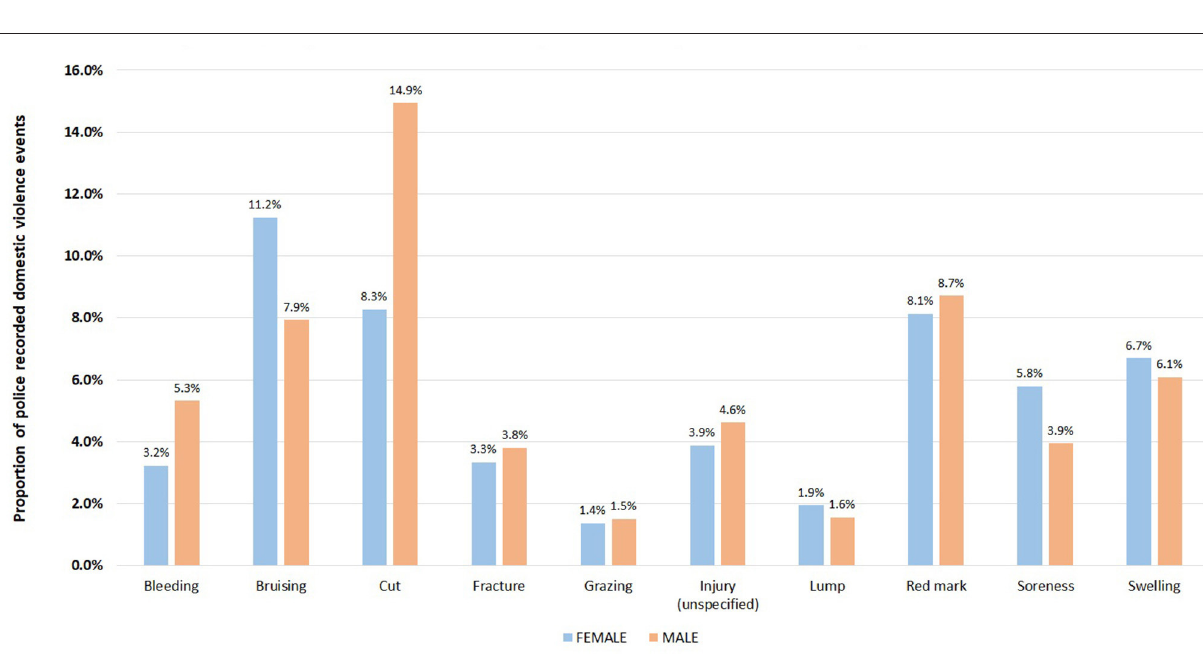
12-year period (e.g., 7.3% vs. 8.1% in 2016). However, the proportion of events reporting attention deficit hyperactivity disorder was almost double for male victims when compared to female victims across all years (e.g., 14.5% vs. 6.8% in